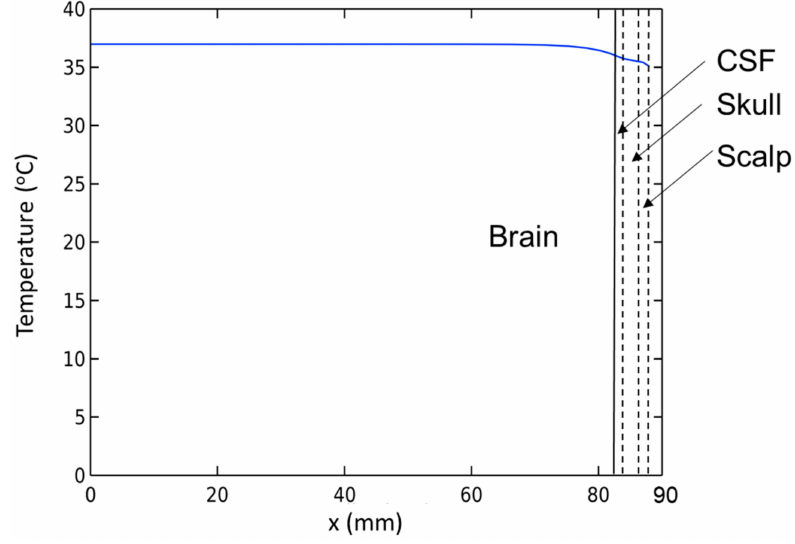
Figure 2. Temperature distribution inside the brain before stimulation.